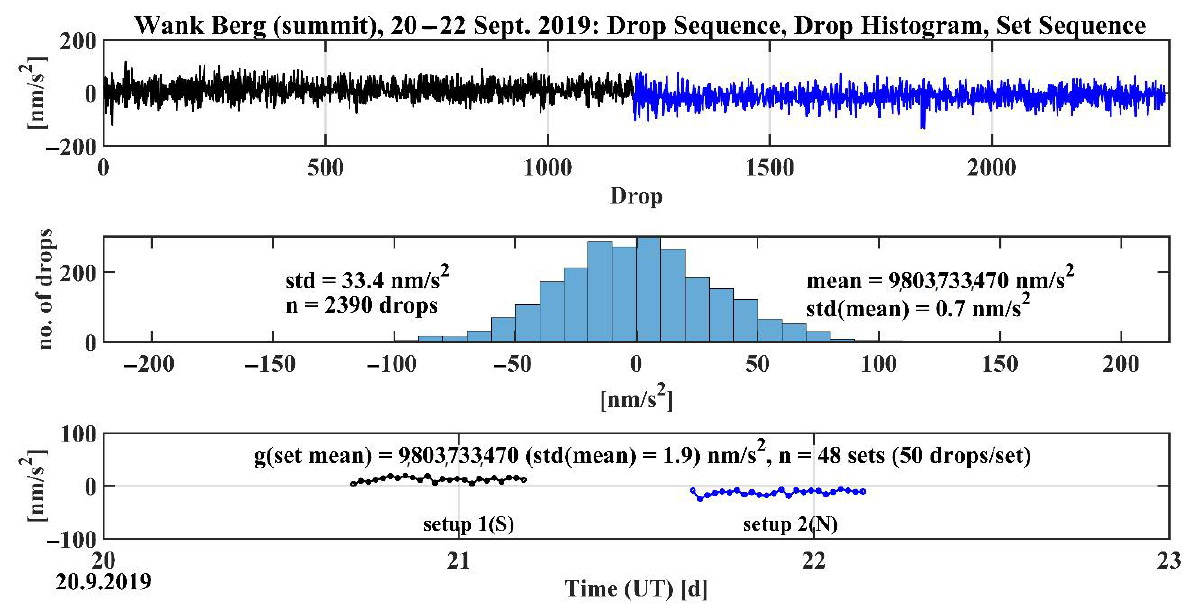
Figure 4. As an example, the statistical compilation of the station determination with the Hannover absolute gravimeter FG5-220 at Wank Berg (2019) is presented.